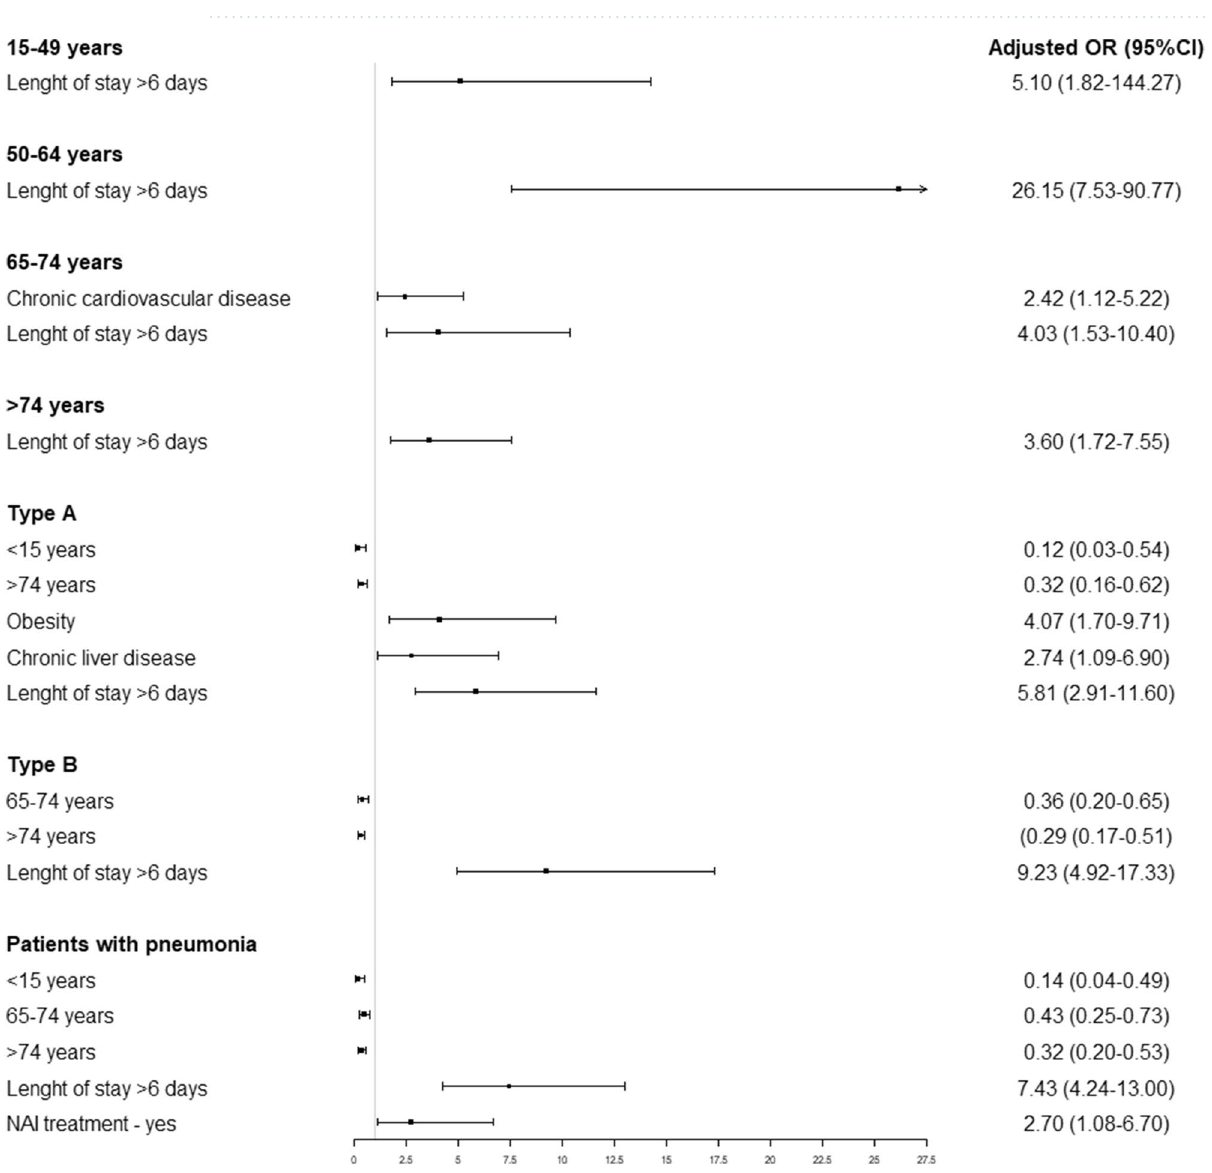
Figure 3. Factors associated with ICU admission in hospitalized severe influenza patients according to age group, influenza type and patients with pneumonia. NAI: neuraminidase